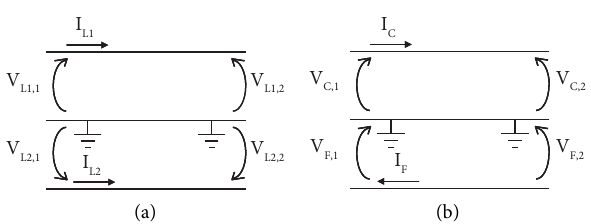
Figure 2: Sketch to illustrate the signs in the line model: (a) traditional line model and (b) required model in accordance with Figure 1.